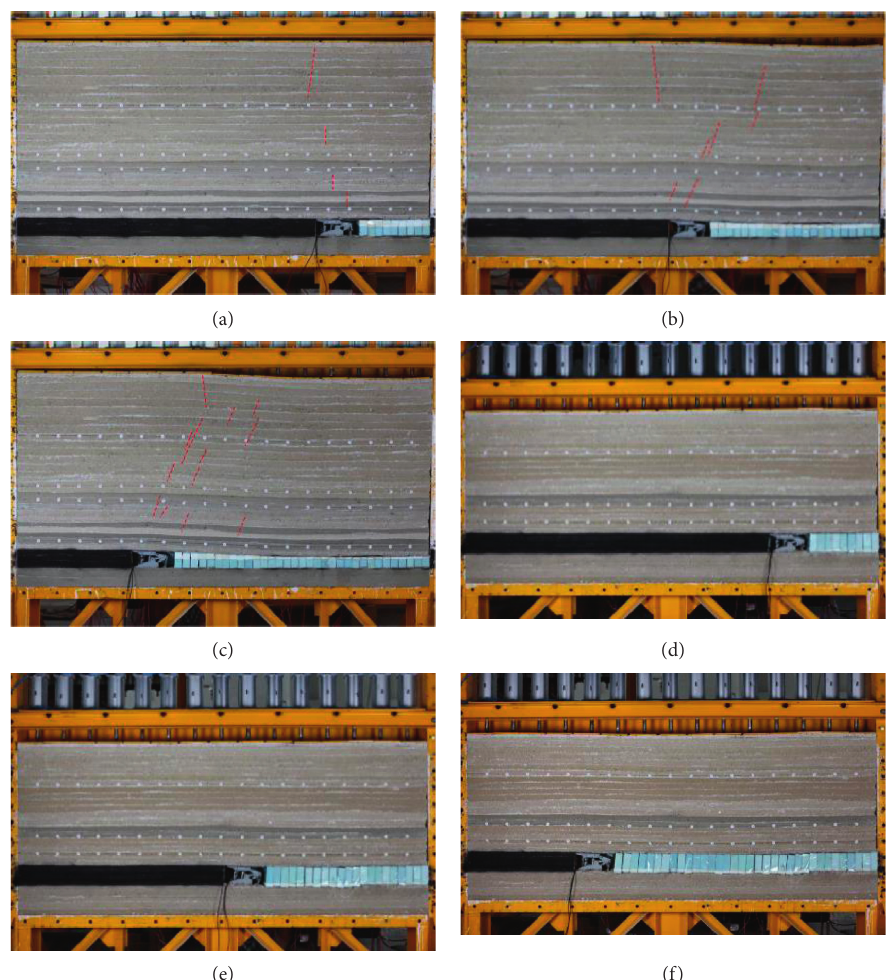
Figure 5: The process of mining and filling and the change of rock strata displacement. (a) Model I, mining length 20m. (b) Model I, mining length 32m. (c) Model I, mining length 49m. (d) Model II, mining length 20m. (e) Model II, mining length 32 m. (f) Model II, mining length